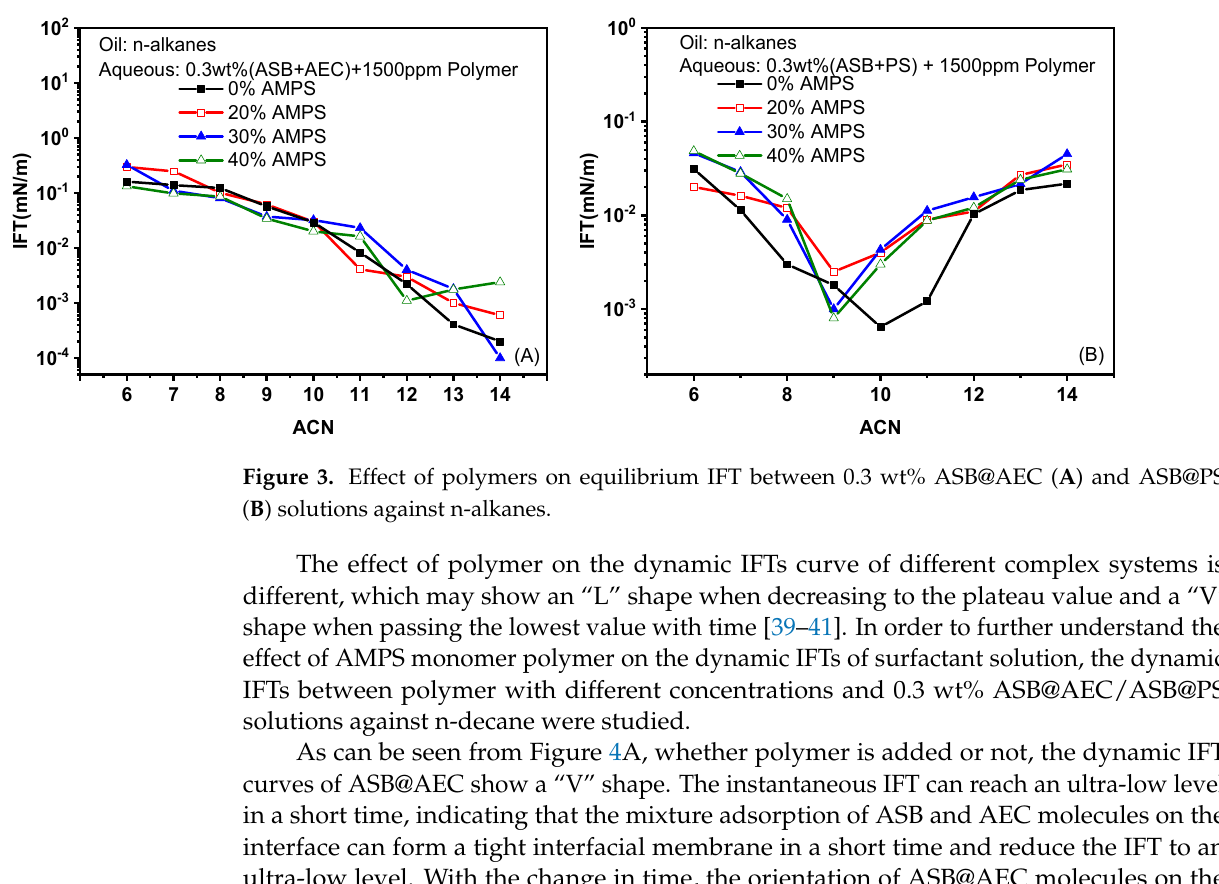
Figure 2. Dynamic IFTs of 0.3 wt% ASB@PS solution ( A ) and equilibrium IFTs of 0.3 wt% ASB@AEC and ASB@PS solutions ( B ) against n-alkanes.